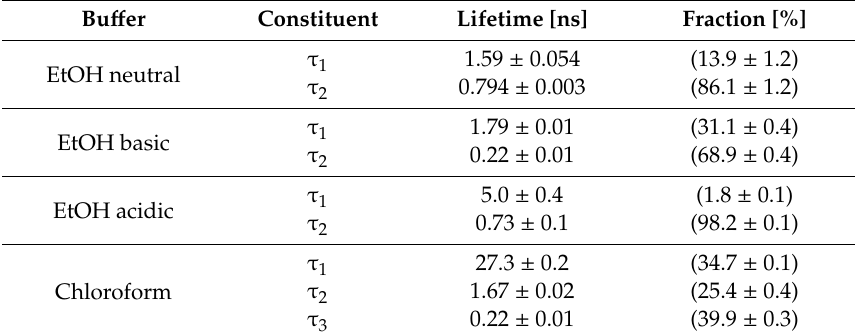
Table 3. Fluorescence lifetimes for FABT measured with the TCSPC method after excitation with a 294 nm